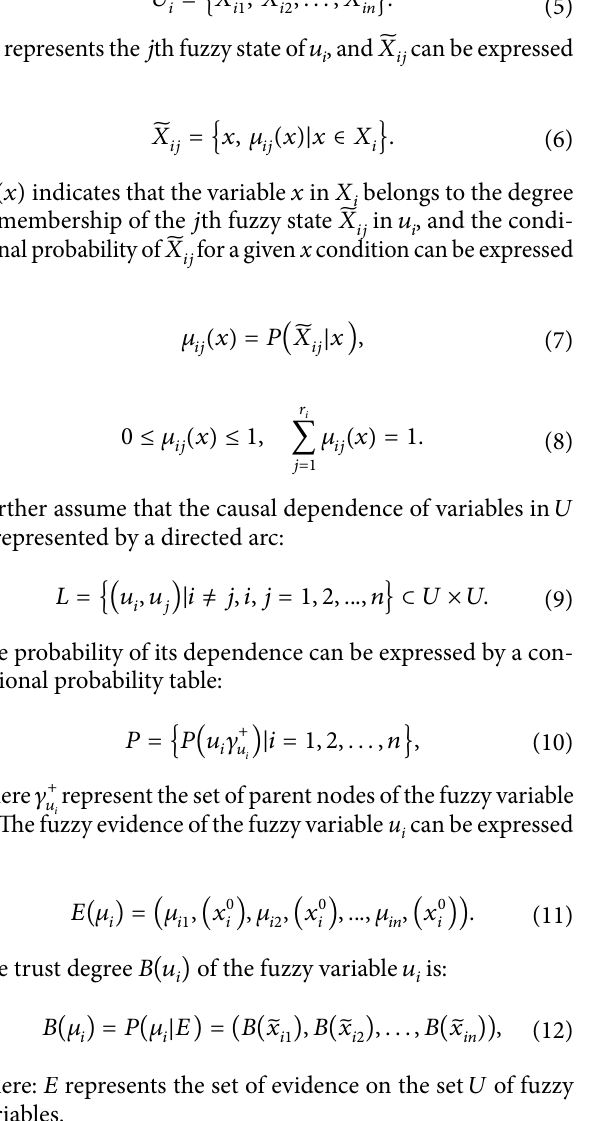
Language description Fuzzy number form λ-cut set Very low